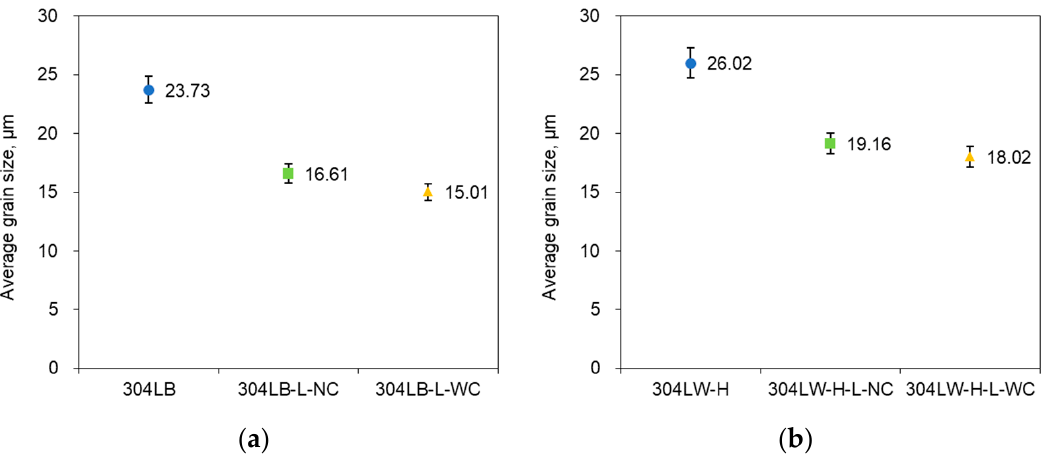
Figure 3. Effect of laser peening on grain size by ASTM E1382; ( a ) Base metal, ( b ) HAZ area.